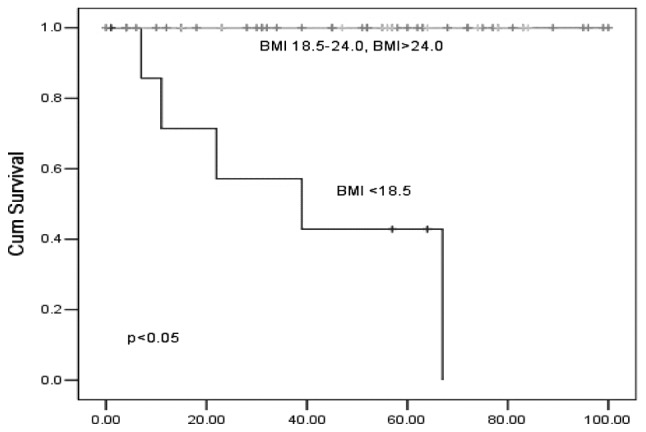
Disease-free interval following curative surgery for patients with colorectal cancer according to preoperative serum levels of carbohydrate antigen 19-9 (CA19-9) in different groups [body mass index (BMI) <18.5, 18.5–24.0 and >24.0]. Cum, cumulative.